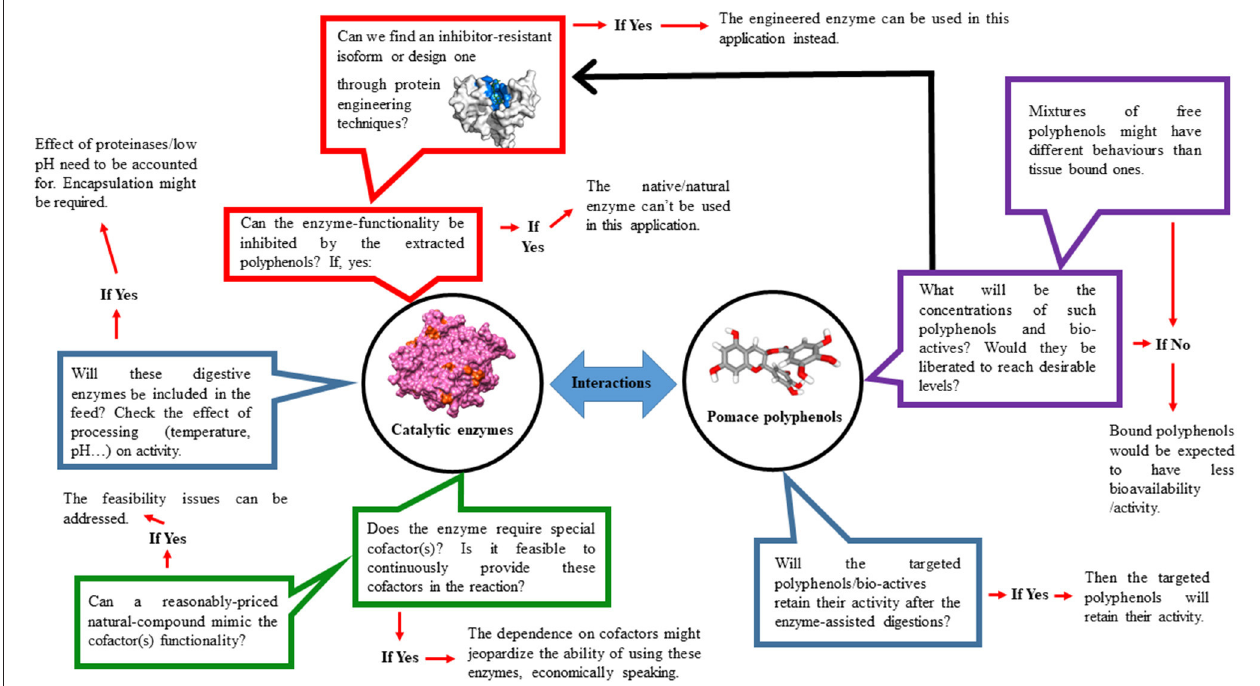
FIGURE 1 | Optimization studies are critically needed when using enzymes and fruit pomaces as animal feed additives. Multiple overlapping factors (pomace composition, its polyphenolic content, enzyme mixes being implemented….) affect the performance of pomaces polyphenols and must be carefully considered for satisfactory and reproducible outcomes.